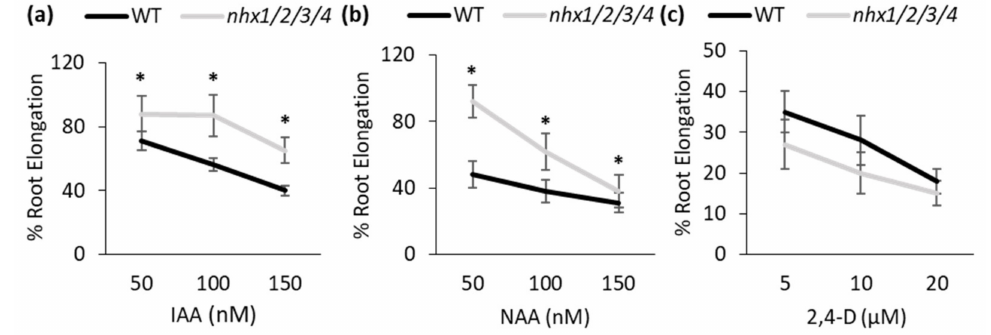
Figure 2. The nhx1nhx2nhx3nhx4 mutant exhibited less sensitivity to IAA and NAA but not to 2,4-D. ( a – c ). Primary root growth of WT and mutant grown on medium supplemented with IAA ( a ), NAA ( b ) and 2,4-D ( c ). Values are the mean ± S.D. (n = 15). Stars indicate significant di ff erences between wild type (WT) and nhx1nhx2nhx3nhx4 (nhx1 / 2 / 3 / 4) in the same concentration of auxin. p < 0.05 by t